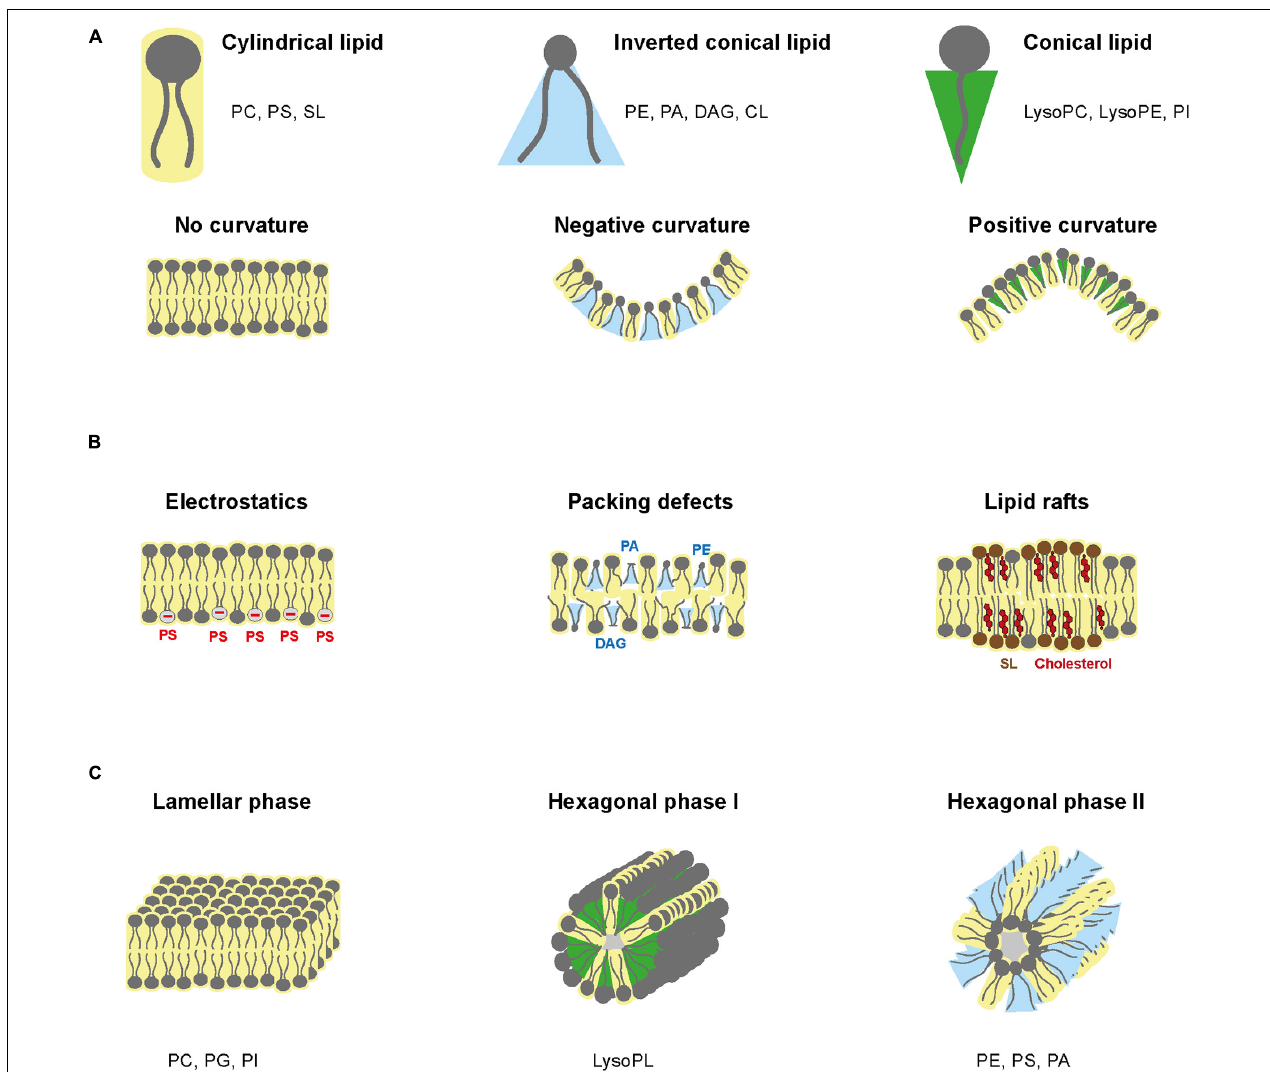
FIGURE 6 | Phospholipid structure and biochemical properties. (A) Spatial hindrance of PLs and the implications for membrane shape. (B) PL influence on electrostatics, packing defects, and lipid rafts. (C) Schematic of lamellar phase, hexagonal phase type I and type II.